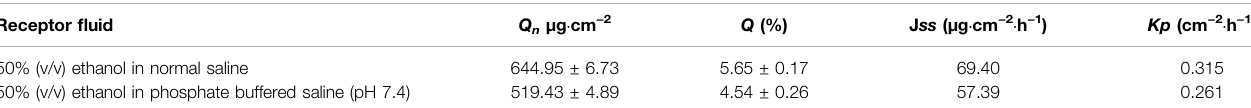
compared the transdermal penetration of free LFs at equal concentrations. As expected, the results of the skin permeability